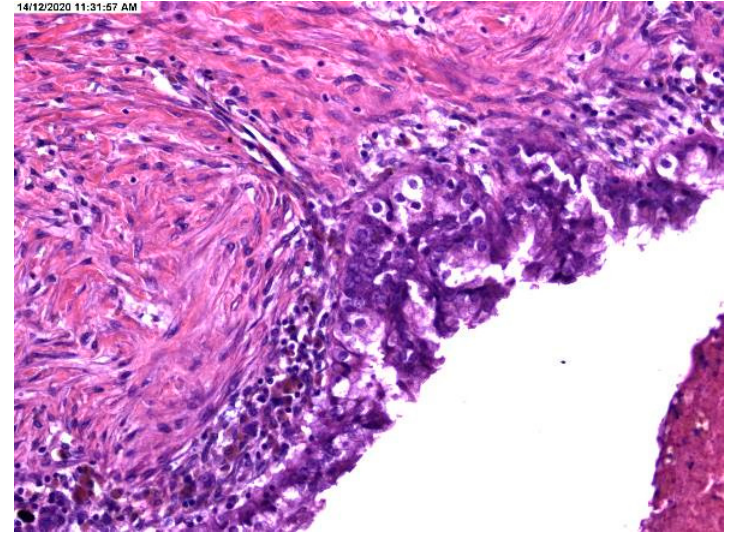
Figure 3. Stratification in the lining of an endometriotic cyst.